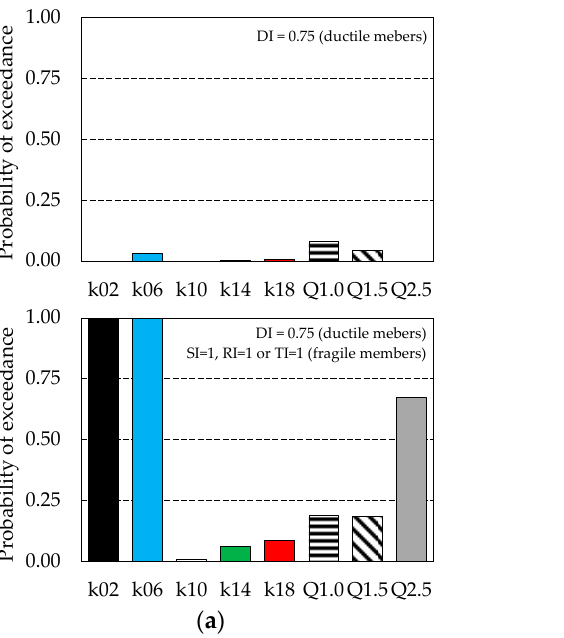
( b ) Figure 3. Fragility curves at the SD limit state of a 4-storey case study: ( a ) Q = 1.0; ( b ) Q = 2.5. 6.2. Response at the SD Limit State The probabilities of exceedance of the SD limit state (i.e., for a g = 0.15 g) obtained for all the considered case studies are represented by the histograms of Figure 4. In particular, Figure 4a,b refer to the 4-storey and 8-storey structures, respectively. Plots in the first line show the results related to ductile members only, while those in the second line show the results obtained considering both the verifications of ductile and fragile members. As a general trend, the probabilities of exceedance of the SD limit state of the consid-